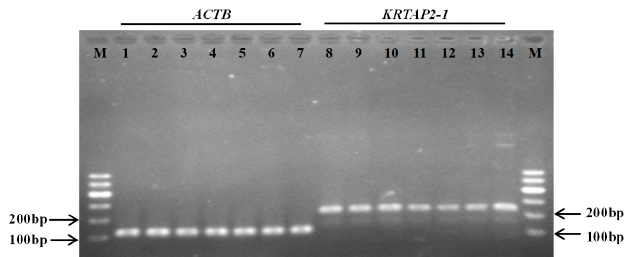
Figure 6. Expression of the keratin-associated protein 2-1 gene in different tissues derived from Gansu Alpine Fine-wool sheep. The keratin-associated protein 2-1 gene transcript was detected in all of the tissues investigated (lanes 8–14) using the beta-actin gene ( ACTB ) as an internal reference standard (lanes 1–7). M: 100 bp deoxyribonucleic acid ladder; lanes 1 and 8: skin; lanes 2 and 9: heart; lanes 3 and 10: liver; lanes 4 and 11: spleen; lanes 5 and 12: lung; lanes 6 and 13: kidney; lanes 7 and 14: longissimus dorsi muscle.